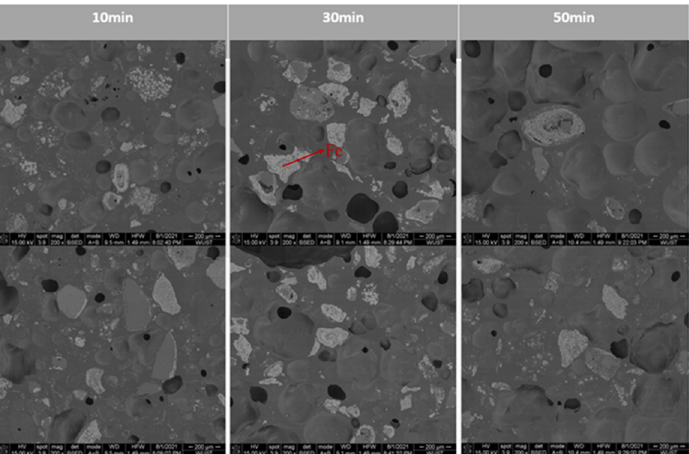
Figure 10. SEM images of iron-carbon micro-electrolytic fi llers with di ff erent sintering times.